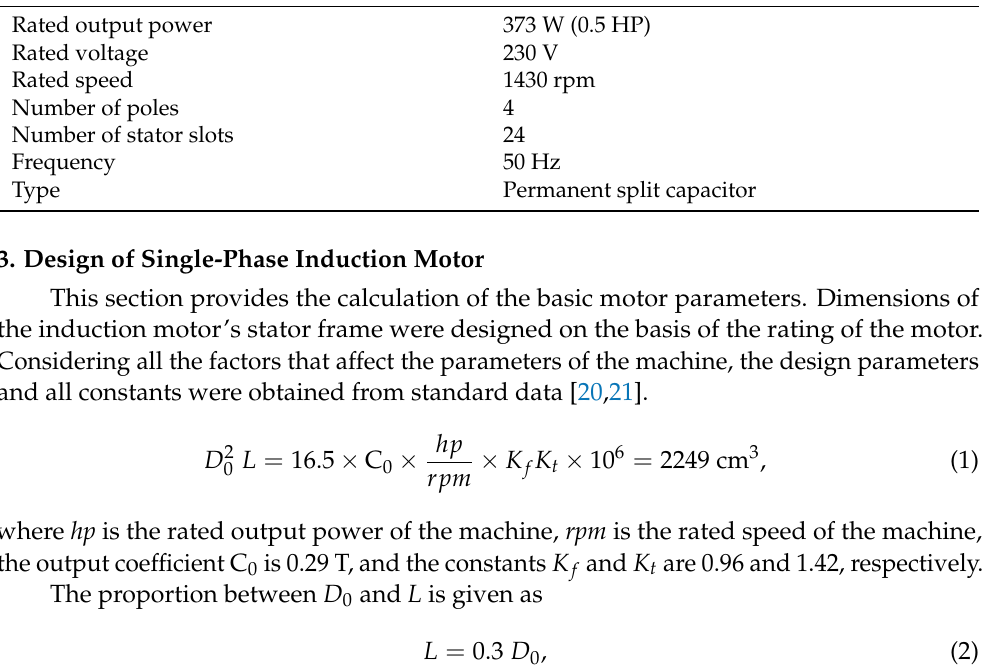
Figure 3. Measuring the dimensions of various parts of the motor. Table 2. Specifications of the single-phase induction motor. Parameters